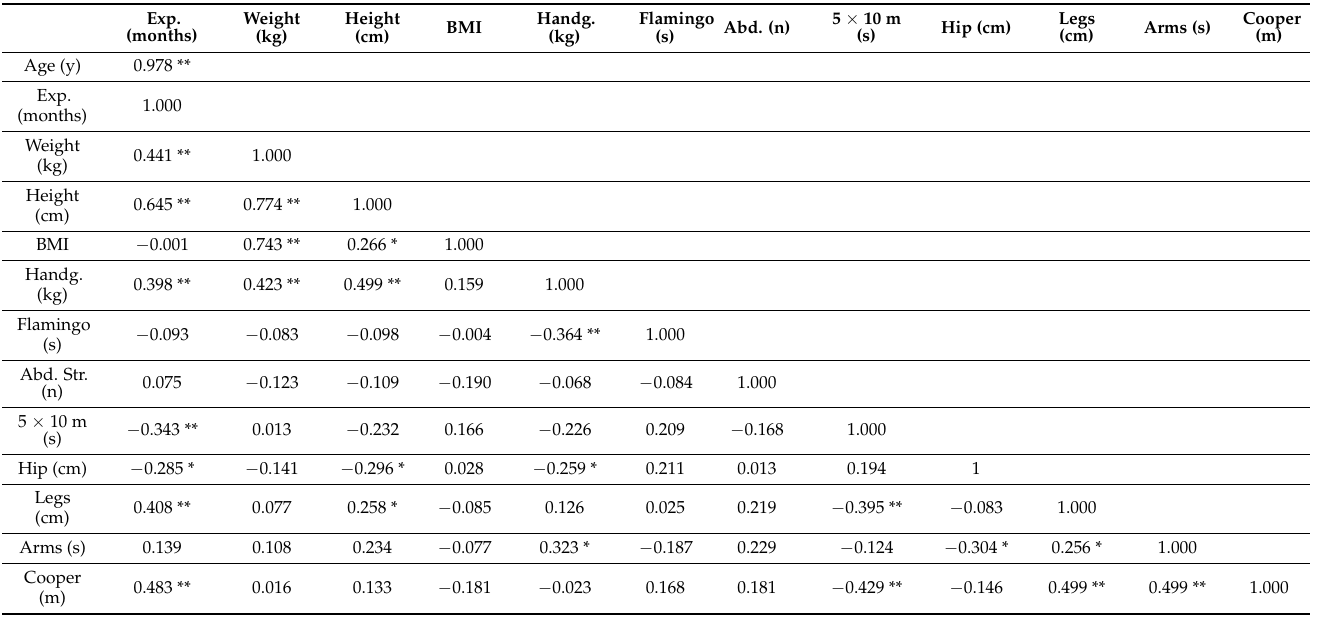
Table 5. Correlation coefficients of fitness values with months of equitation